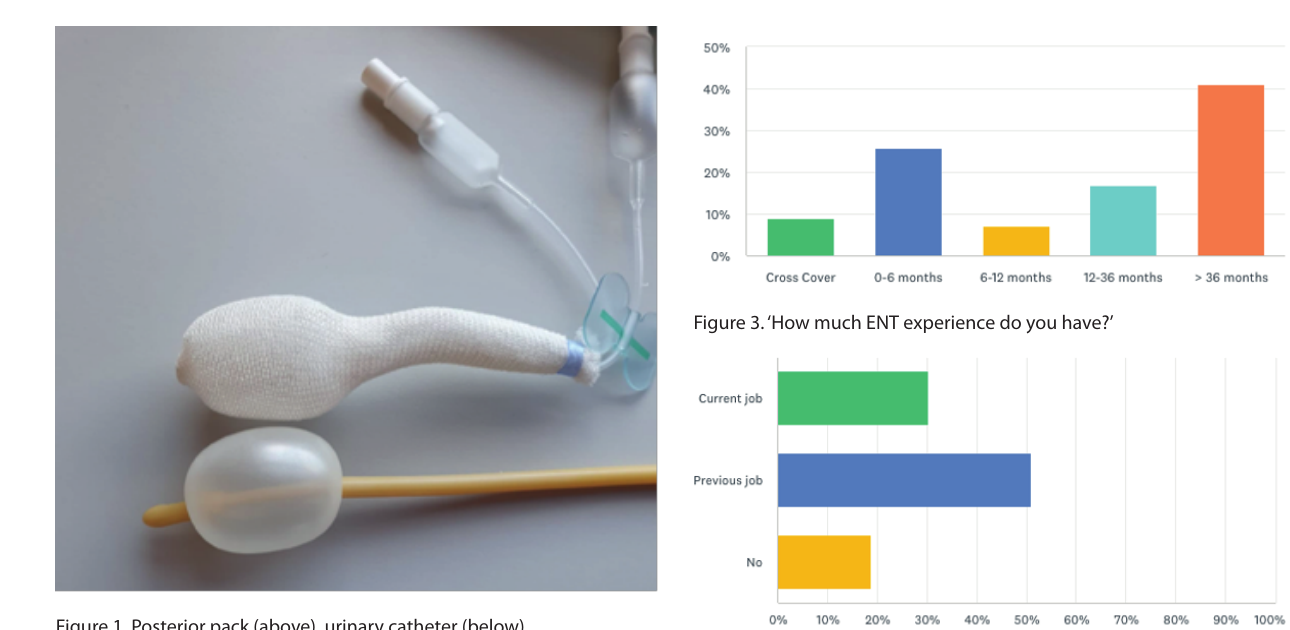
Figure 4. ‘Have you personally been given any training or induction on the management of posterior epistaxis with either posterior packs or catheters?’